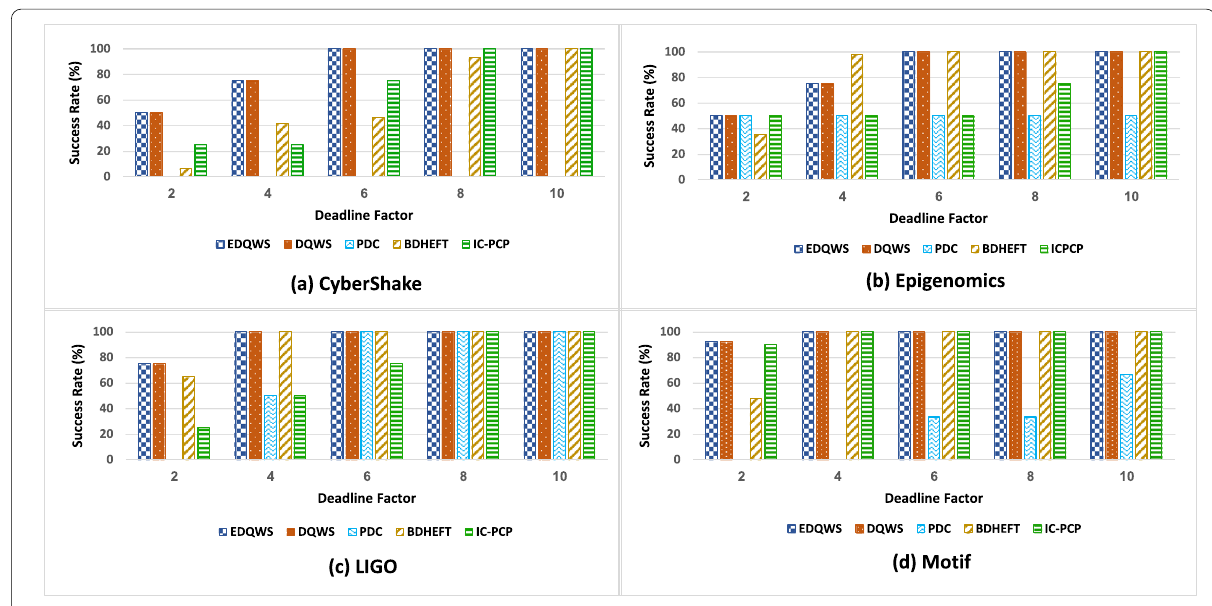
Fig. 12 Success rates of the compared algorithms on the four workflow